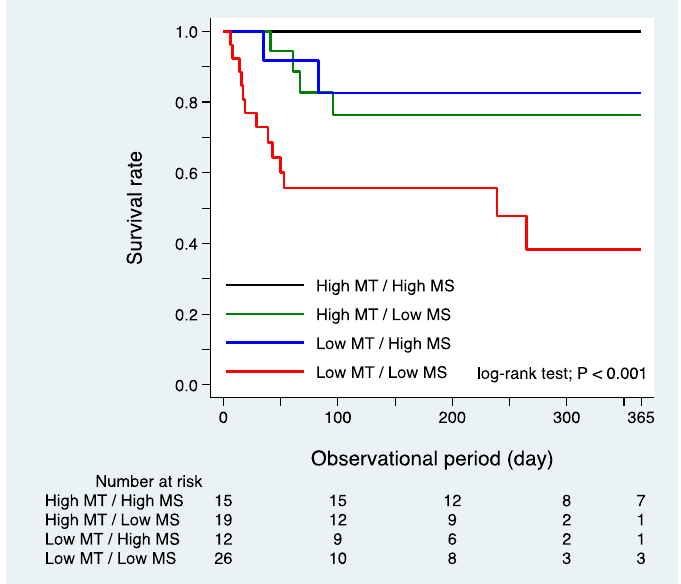
Figure 1. Kaplan–Meier analysis of 1-year mortality according to sarcopenia defined by low muscle mass and strength in the ICU. MT: muscle thickness, MS: Muscle strength.